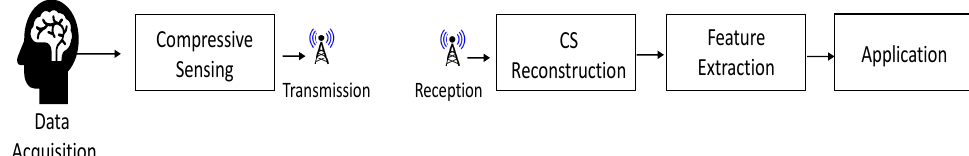
Figure 1. Block diagram of CS-based EEG